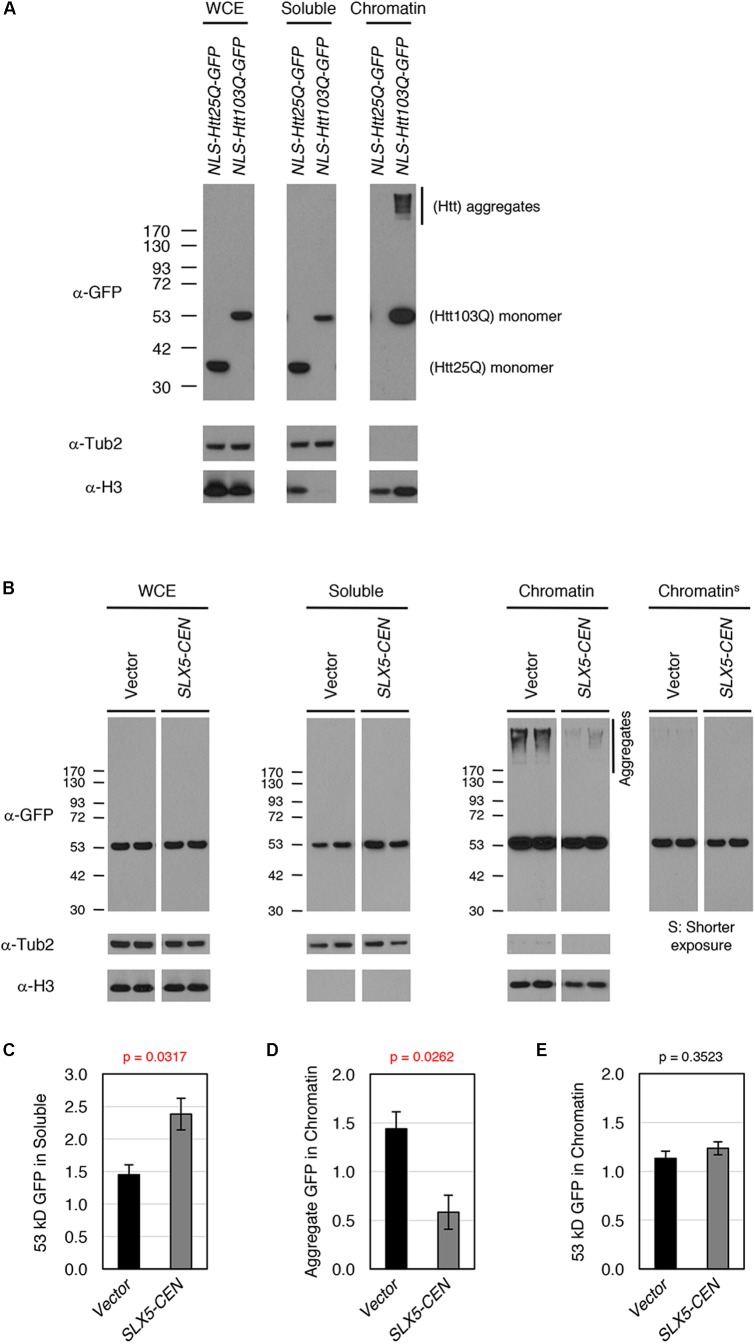
Slx5 reduces the level of chromatin associated Htt103Q aggregates. (A) Htt103Q, but not Htt25Q, associates with chromatin. Whole cell extracts (WCEs) prepared from equal numbers of cells expressing GFP-tagged Htt25Q-NLS or Htt103Q-NLS from a GAL promoter were fractionated into soluble and chromatin fractions. Htt25Q-NLS-GFP or Htt103Q-NLS-GFP levels in each fraction were monitored by western blot analysis with anti-GFP antibody. Tub2 and histone H3 were used as markers for soluble and chromatin fractions, respectively. (B) WCEs prepared from equal numbers of cells expressing Htt103Q-NLS-GFP with (SLX5-CEN) or without (Vector) were fractionated into soluble and chromatin fractions as described in A. Htt103Q-NLS-GFP levels were monitored by western blot analysis with anti-GFP antibody. Three independent transformants were assayed and shown are the results from two of these. (C) Quantification of the 53 kD GFP signals in soluble fraction from 4B. The 53 kD GFP was normalized using Tub2 levels in soluble fraction. The graph represents the mean of three independent clones with SEM. P-value is 0.0317. (D) Quantification of the aggregate GFP signals in chromatin fraction from 4B. The aggregate GFP signal was normalized using H3 levels in chromatin fraction. The graph represents the mean of three independent transformants with SEM. P-value is 0.0262. (E) Quantification of the 53 kD GFP signals in chromatin fraction from 4B. The 53 kD GFP (shorter exposure) was normalized using H3 levels in chromatin fraction. The graph represents the mean of three independent transformants with SEM. P-value is 0.3523.